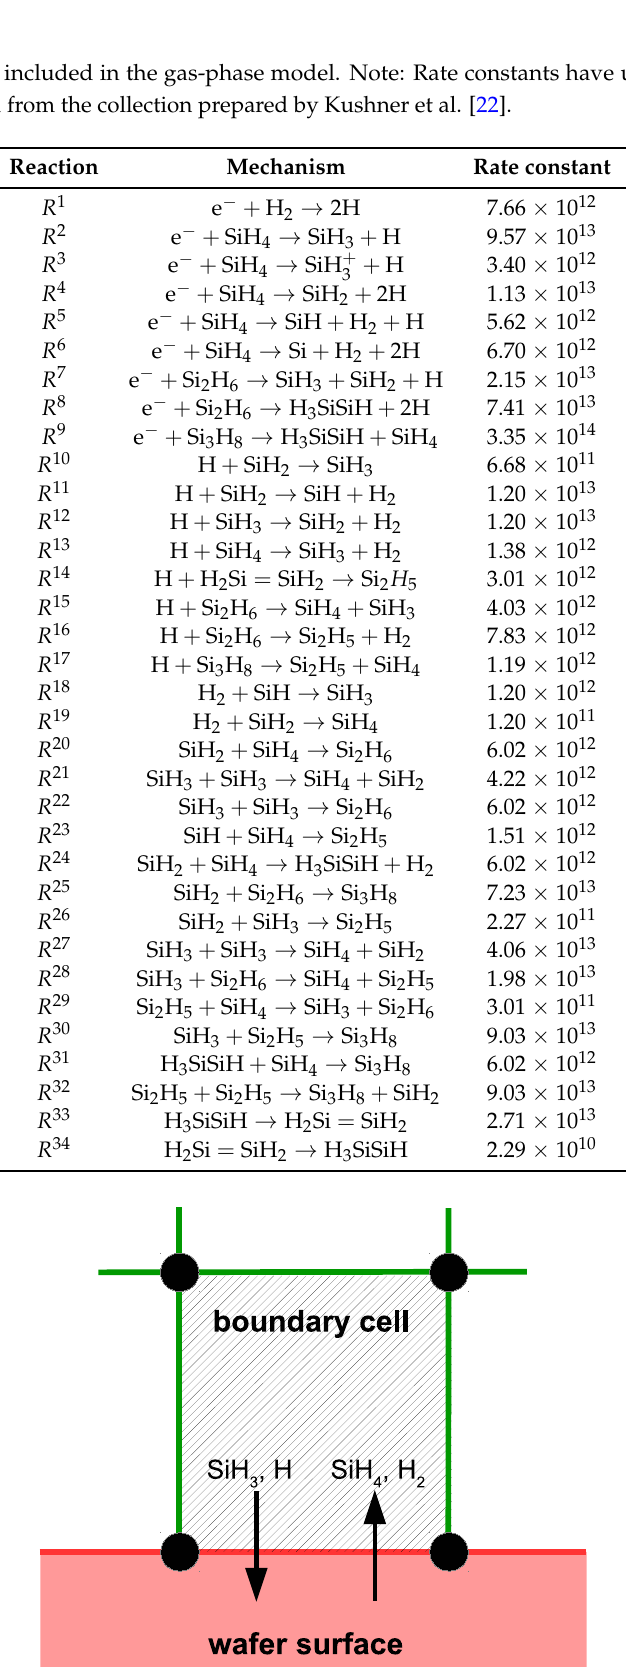
Figure 5. Boundary cell adjacent to wafer